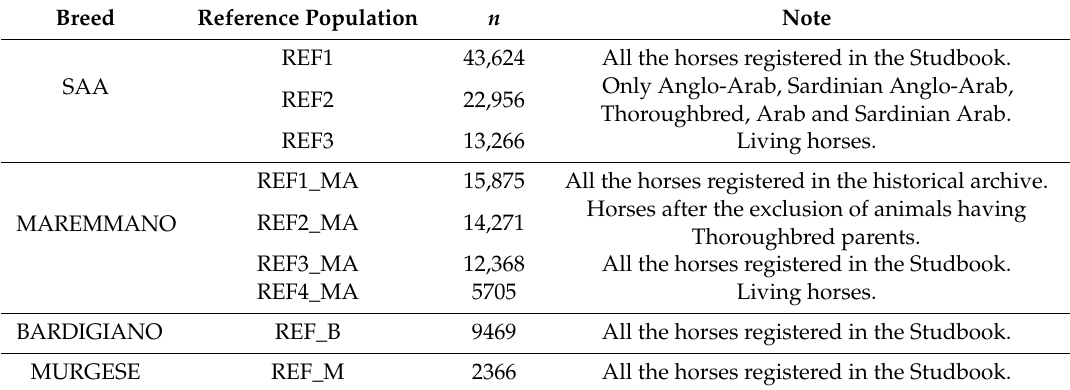
Table 1. Sardinian Anglo-Arab reference populations compared with other Italian horse breeds. Breed Reference Population n Note REF1 43,624 All the horses registered in the Studbook. Only Anglo-Arab, Sardinian Anglo-Arab, SAA REF2 22,956 Thoroughbred, Arab and Sardinian Arab. REF3 13,266 Living horses. REF1_MA 15,875 All the horses registered in the historical archive. Horses after the exclusion of animals having REF2_MA 14,271 MAREMMANO Thoroughbred parents. REF3_MA 12,368 All the horses registered in the Studbook. REF4_MA 5705 Living horses. BARDIGIANO REF_B 9469 All the horses registered in the Studbook. MURGESE REF_M 2366 All the horses registered in the